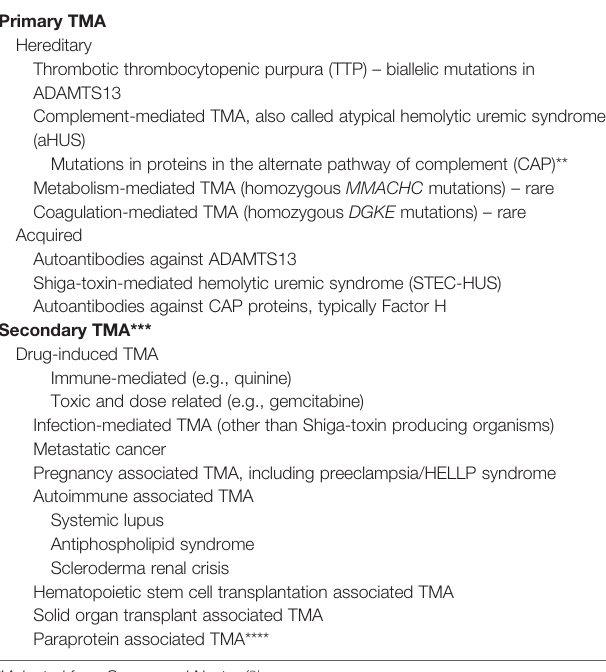
TABLE 2 | Syndromes of Thrombotic Microangiopathy